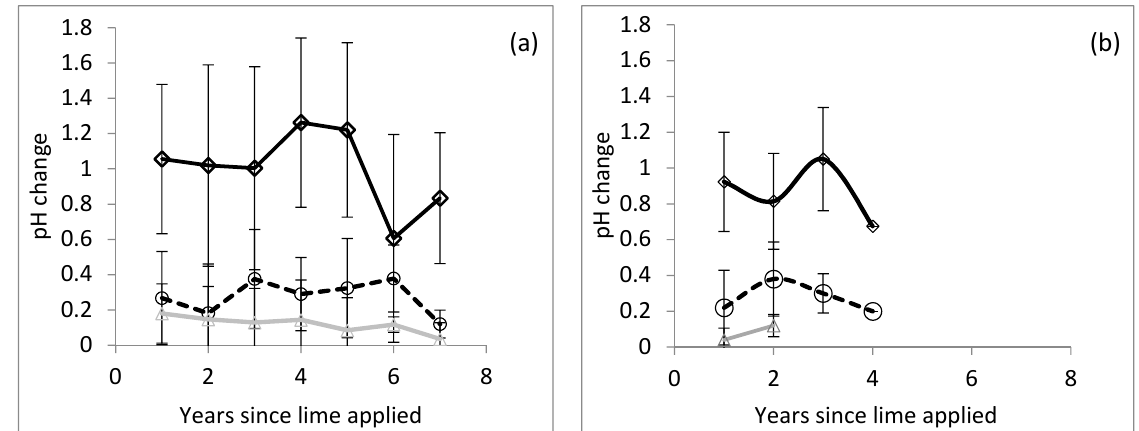
Figure 4. Change in soil pH (CaCl 2 ) after liming in the 0–0.1 m ( ♦ ), 0.1–2 m (o) and 0.2–0.3 m ( ∆ ) layers with years since lime applied for the WA cases ( a ) and NSW and VIC cases ( b ). Error bars indicate +/ − 1 standard deviation.